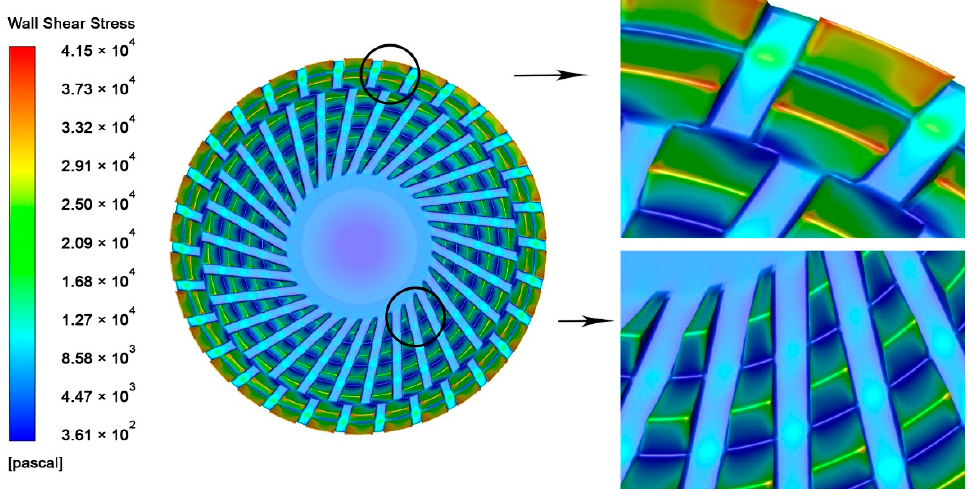
Figure 4. Shear stress on the surface of the rotor.